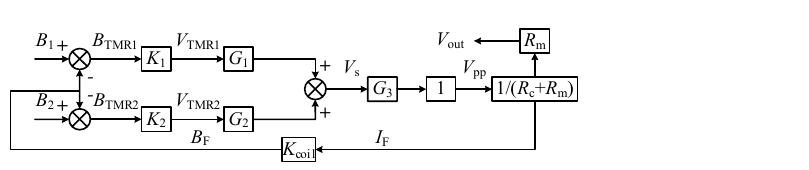
Figure 2. Mathematical model of dual air-gap closed-loop TMR current